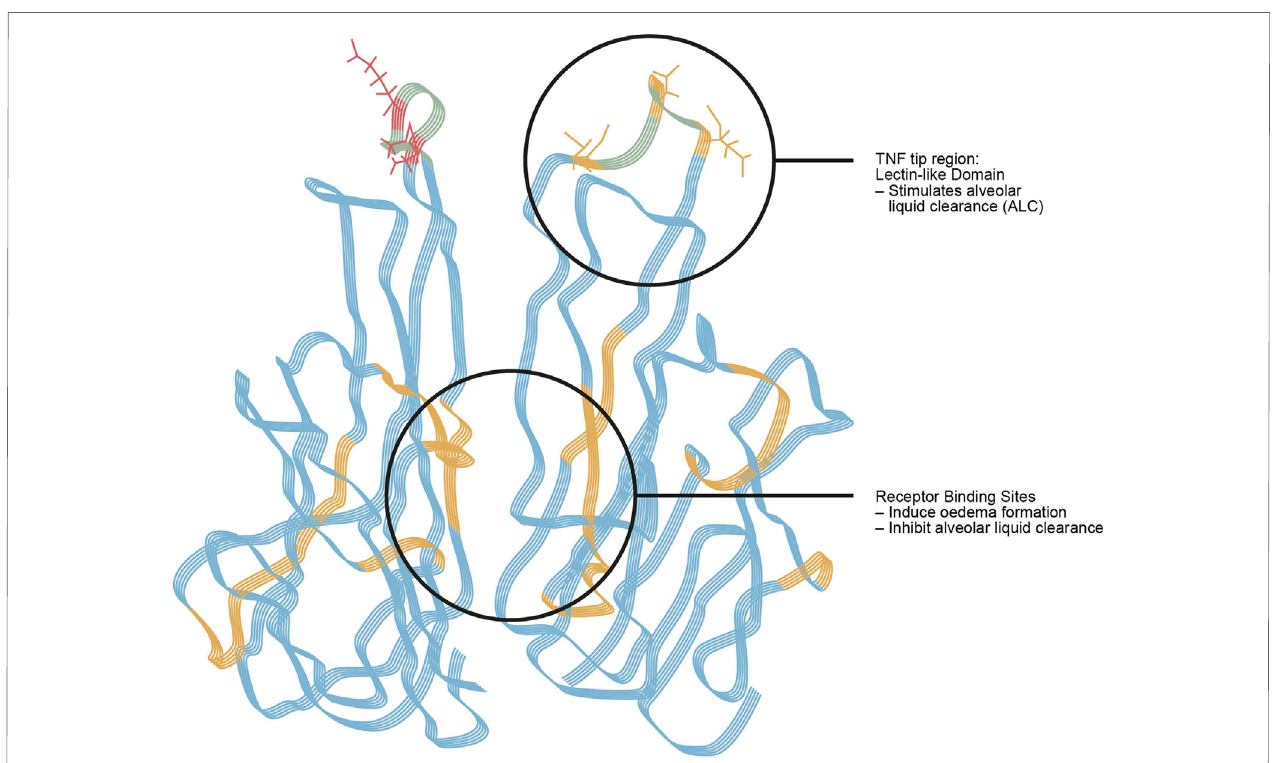
FigURe 7 | Tumor necrosis factor. Tumor necrosis factor (TNF) as a “moonlighting” or dual role, or dichotomal yin-yang cytokine. The TNF receptor 1 binding sites within the TNF homotrimer mediate edema formation and blunt edema reabsorption. The lectin-like domain of the same cytokine activates epithelial sodium channel function and as such promotes alveolar fluid clearance and acts on endothelial cell barrier tightness